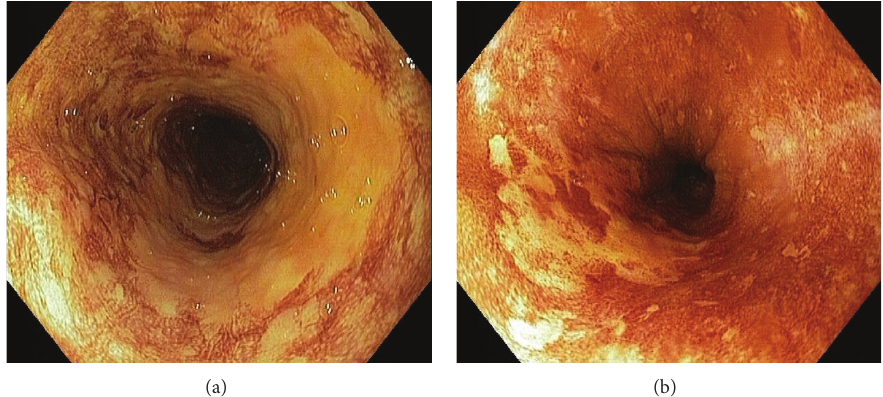
Figure 4: Endoscopic views of the Lugol chromoendoscopy in patients with head and neck cancer. (a) Irregularly shaped multiform LVLs (histologically identified as spinocelullar carcinoma). (b) Single LVL on 7 o’clock position (histologically high-grade